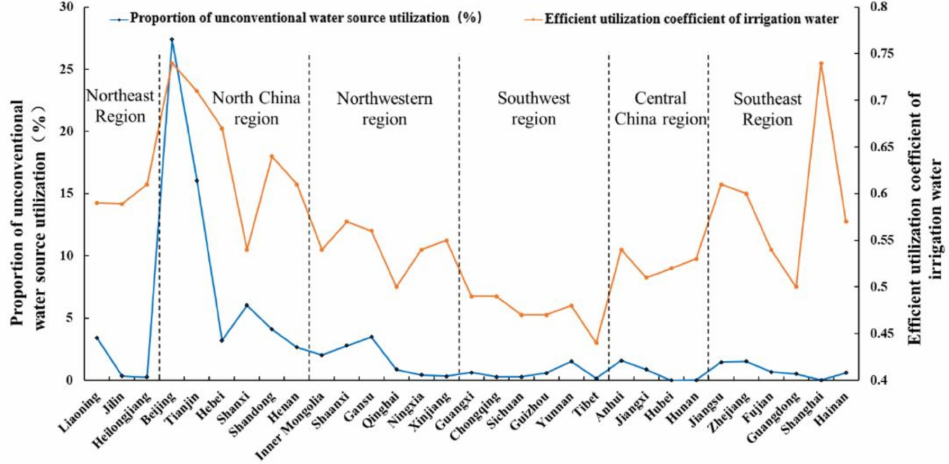
Figure 8. Low-level indicators district statistics